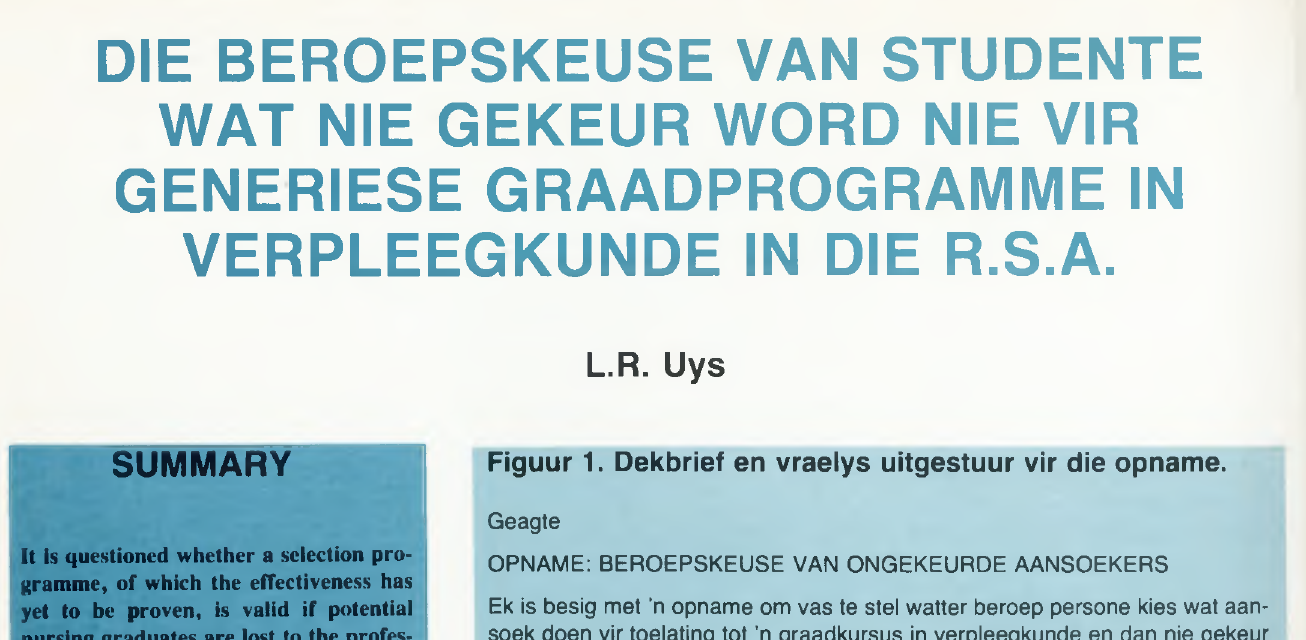
Figuur 1. Dekbrief en vraelys uitgestuur vir die opname.